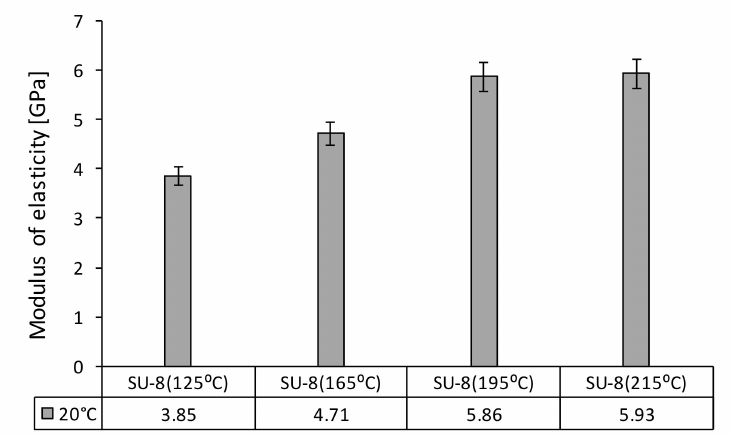
Figure 4. Modulus of elasticity of SU-8 hard baked at 125 ◦ C, 165 ◦ C, 195 ◦ C, 215 ◦ C tested at 20 ◦ C.